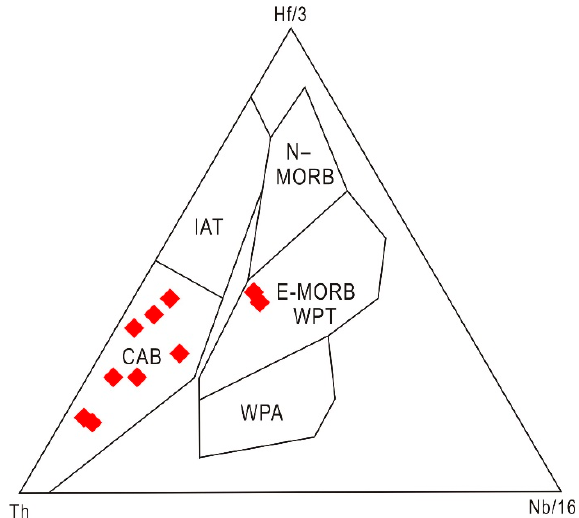
Figure 12. Th–Hf–Nb triangular discrimination diagram (after [71]) for the Haoyaoerhudong gabbro.